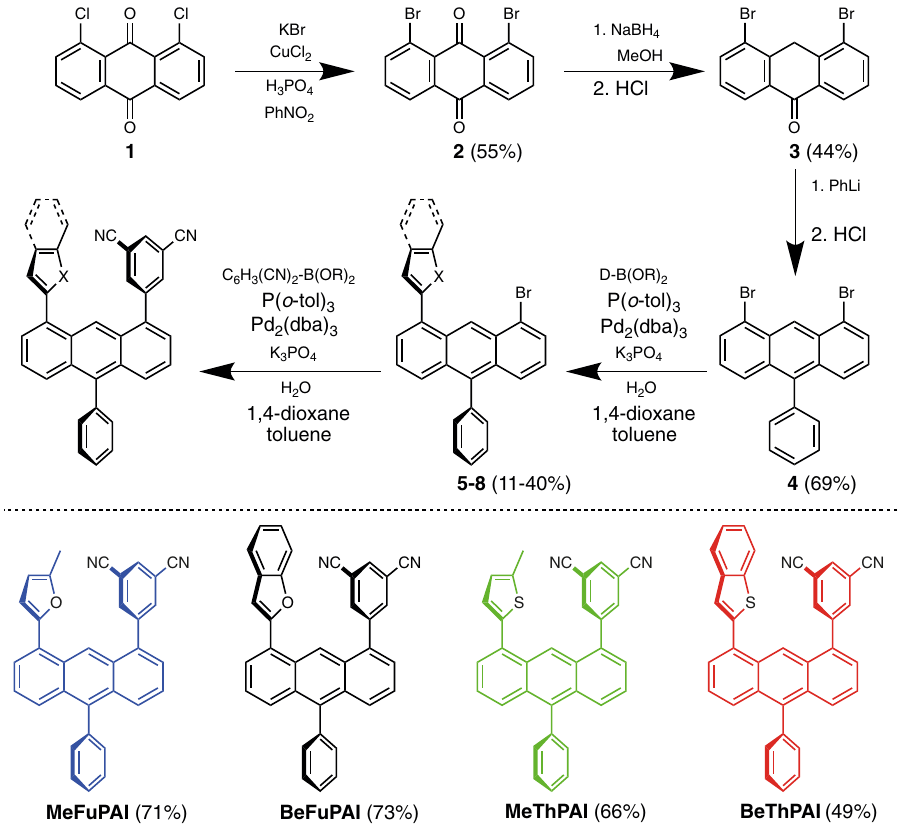
Fig. 2 Synthetic route yielding the hot exciplex emitters. 5-(8-(5-Methylfuran-2-yl)-10-phenylanthracen-1-yl)isophthalonitrile (MeFuPAI), 5-(8-(benzofuran- 2-yl)-10-phenylanthracen-1-yl)isophthalonitrile (BeFuPAI), 5-(8-(5-methylthiophen-2-yl)-10-phenylanthracen-1-yl)isophthalonitrile (MeThPAI), and 5-(8- (benzo[b]thiophen-2-yl)-10-phenyl-anthracen-1-yl)isophthalonitrile (BeThPAI). Yields of the fi nal coupling step are indicated in parentheses. Detailed reaction procedures are provided in Supplementary Note